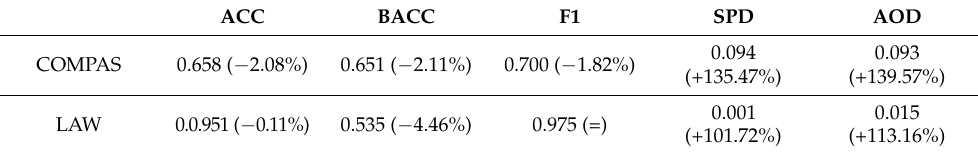
Table 8. LRC results after reweighing the training and test set. Performance was evaluated on ten re- peated train-test splits. For SPD and AOD. values closer to zero indicate more fairness. The percentages in brackets display the differences compared to a baseline LRC evaluated on equal train-test